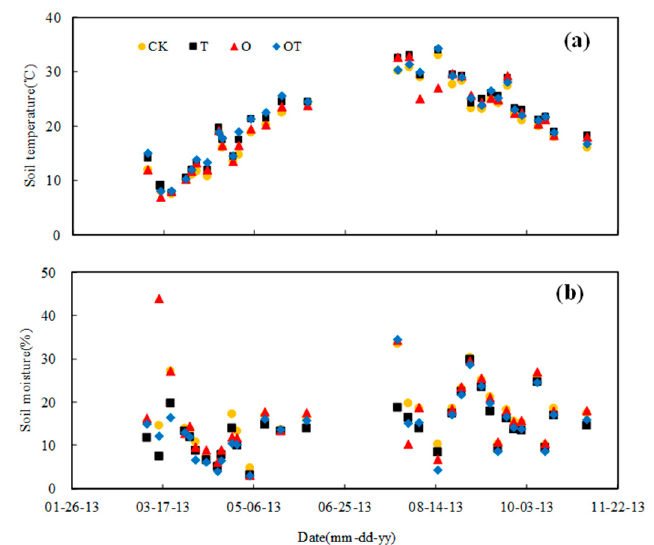
Figure 1. Seasonal variation in soil temperature and moisture: ( a ) Temperature in the winter wheat and soybean-growing seasons; ( b ) Moisture in the winter wheat and soybean-growing seasons.